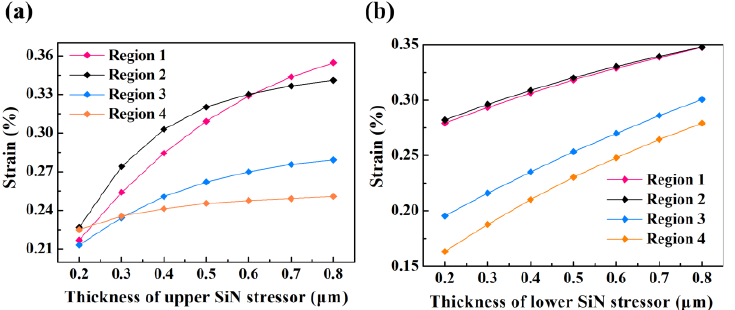
Figure 2. The introduced strain ε xx values in regions 1 – 4 for different thickness of ( a ) upper SiN stressor layer and ( b ) lower SiN stressor layer. Figure 3 simulates the in-plane strain ε xx in Ge for structure 4 with different mesa diameters under the same SiN stressor setting. In the previous study, the ε xx in Ge